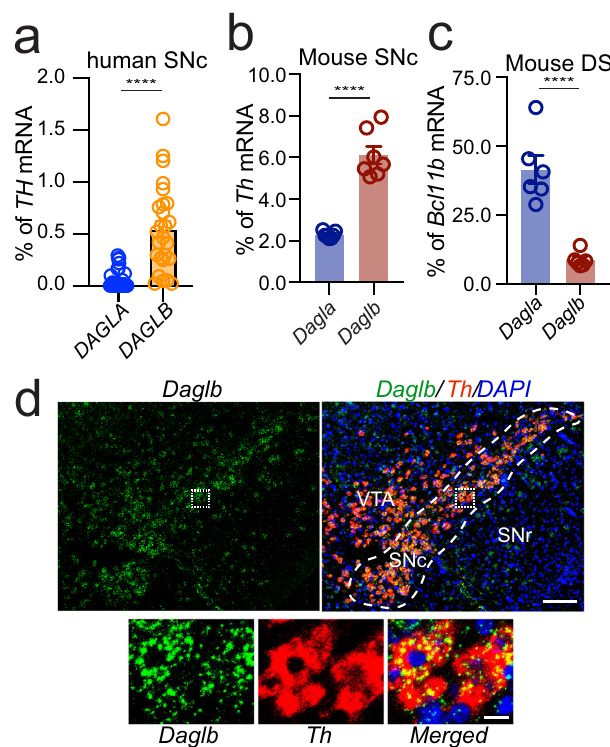
Fig. 2 DAGLB is the main 2-AG synthase expressed by the nigral DANs. a Quanti fi cation of DAGLA and DAGLB mRNA expression by RNA- sequencing of LCM-isolated human nigral DAN samples ( n = 26) 29 . b Quanti fi cation of Dagla and Daglb mRNA expression by RNA-sequencing of LCM-isolated nigral DANs from adult mouse brains ( n = 7). c Dagla and Daglb mRNA expression in the mouse dorsal striatum (DS, n = 6). The expression of Dagla and Daglb mRNAs was normalized by the expression of Th mRNAs in the nigral DANs and Bcl11b mRNAs in the SPNs. Data were presented as mean ± SEM. Unpaired t test, two-tailed, **** p < 0.0001. d RNAscope ® in situ hybridization of Daglb and Th in mouse midbrain sections. Sections were counterstained with DAPI. Dashed line outlines the SNc region. Bottom panels highlight the boxed areas in the up panels. SNc: substantia nigra pars compacta. SNr: substantia nigra pars reticulata. VTA: ventral tegmental area. Scale bars: 100 μ m (left) and 20 μ m (right). More than fi ve independent experiments were